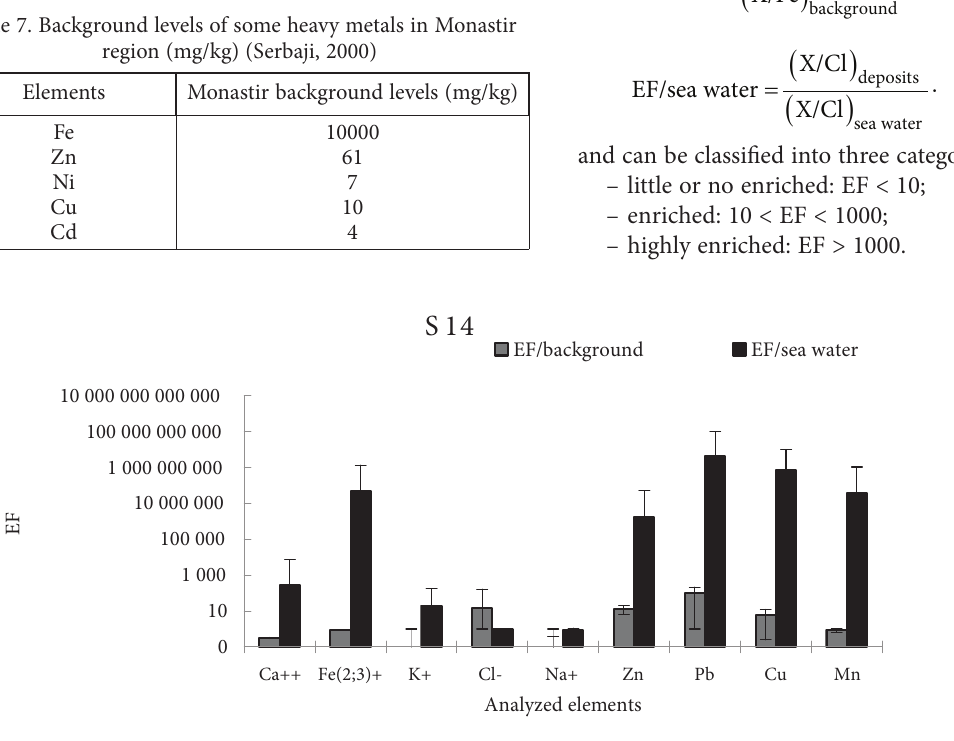
Figure 10. Enrichment factors of particle deposition constituents referred to Fe and Cl (for S14